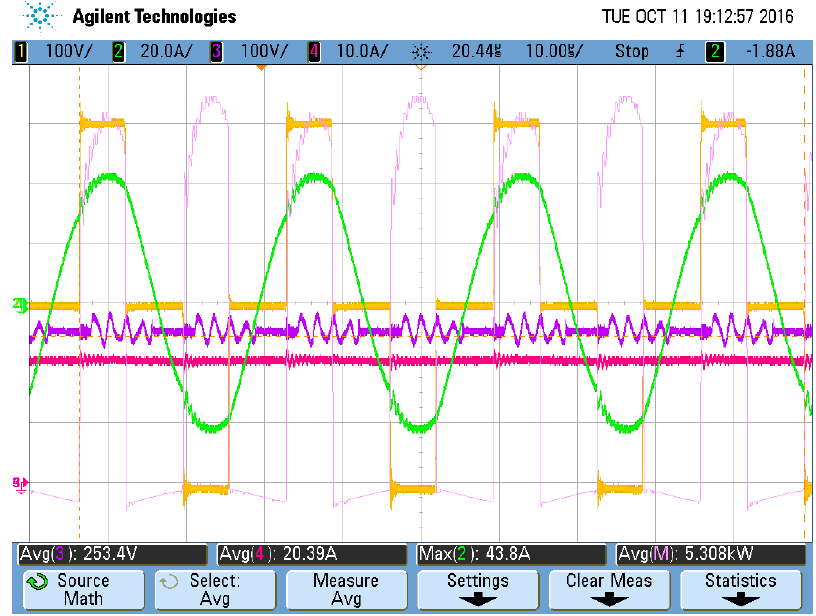
Figure 14. Experimental waveforms for V AB (yellow) and i PL (green), with V in = 300 V, V O = 250 V and P O = 5 kW.